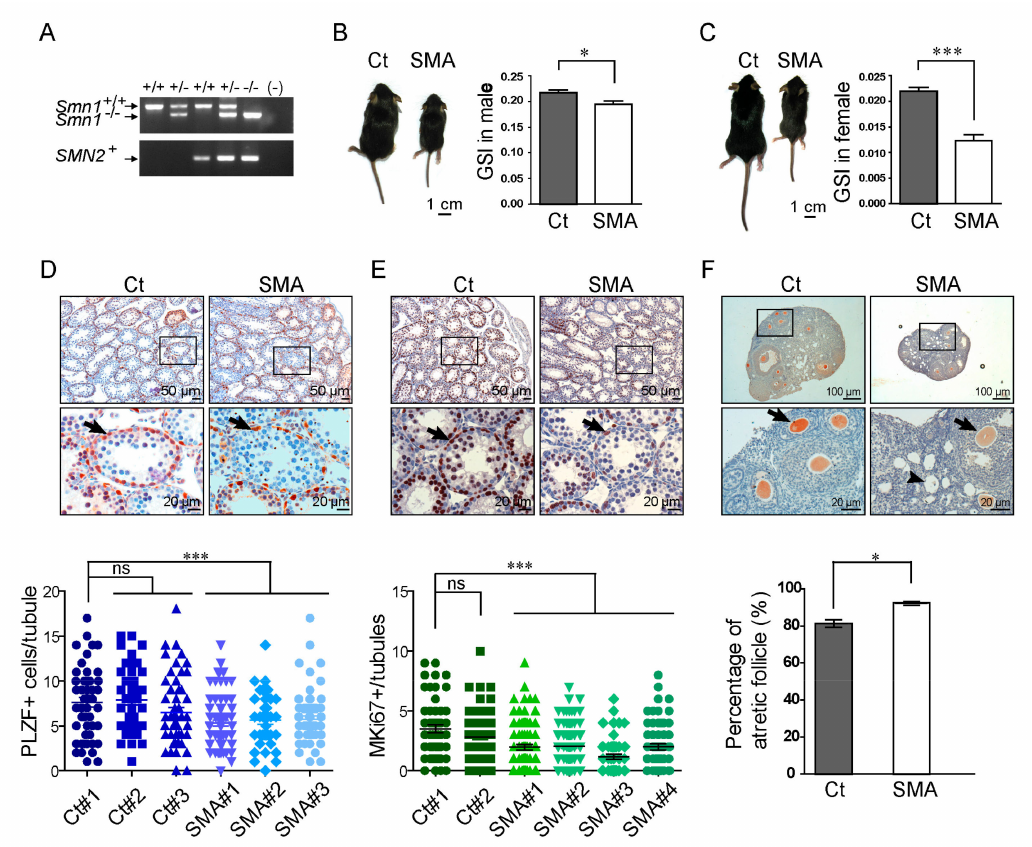
Figure 2. Testes and ovaries in SMA-like mice are abnormal. ( A ) Genotype of wildtype Smn1 +/+ ;SMN2 − , Smn1 +/ − ;SMN2 + (littermate control, Ct), and Smn1 − / − ;SMN2 + (SMA-like) mice are confirmed by PCR. (-) indicates the negative control without a template. ( B ) Male SMA-like mice (indicated as SMA) with a phenotype has a smaller body size and significantly lower GSI than their heterozygote littermates ( Smn1 +/ − SMN2 + , indicated as Ct) at the age of 2 weeks ( n = 4 Ct and 7 SMA mice). ( C ) The body size of female SMA-like mice (left panel), and the GSI of ovaries at 8 weeks after birth (right panel, n = 3 Ct and 4 SMA mice). ( D ) Reduction of PLZF-expressing germ cells (red color, arrows in larger magnification field) is shown in SMA-like mice but not in their heterozygote littermates after IHC analysis. Lower panel indicates its quantification. Each spot indicates the number of PLZF-expressing cells in each seminiferous tubule. Seminiferous tubules ranging from 100 to 150 µ m are used for counting ( n = 3 mice per genotype). ( E ) The expression of the proliferation marker, MKi67 (red color, arrow), is weaker in surrounding spermatogonia cells on the basal membrane of SMA-like mice than heterozygote controls. Hematoxylene was used as a counterstain (blue) ( n = 2 for Ct and 4 for SMA). The negative control of IHC is shown in Supplementary Figure S3. ( F ) IHC staining demonstrates low SMN protein levels (red color, arrow) in the immature oocytes in SMA-like mice. The percentage of atretic follicles (atresia) was quantified (lower panel). * Indicates a statistically significant di ff erence, p < 0.05. ***, p <